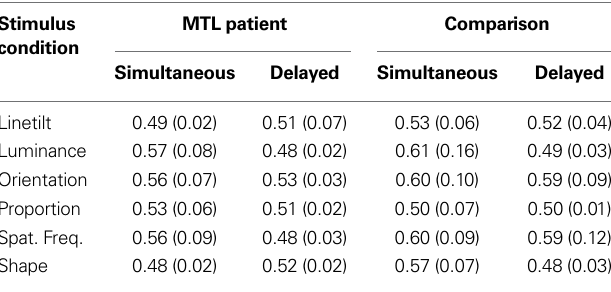
Table 2 | Mean behavioral performance (proportion correct) and standard error in parentheses by stimulus condition, participant group, and delay